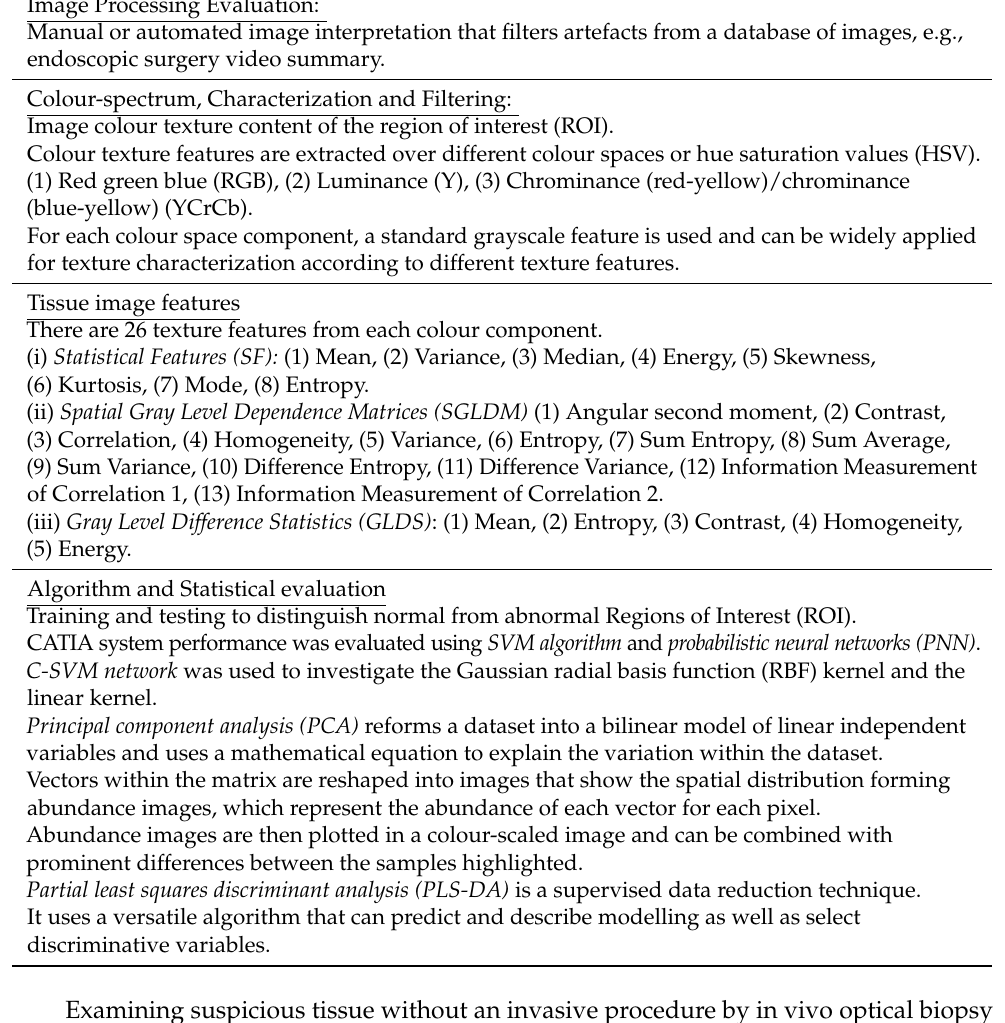
Table 1. Summary and Indexing of tissue image processing terminology and techniques. Image Processing Evaluation: